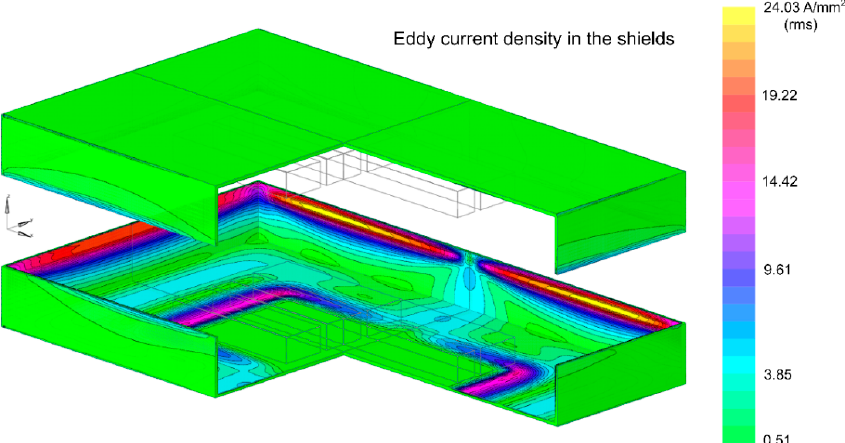
Figure 6. Eddy current density distribution in the shields when only the lower winding is fed. The maxima occur near the edge of the longer sides of the shield. Eddy currents (as well as all the other causes of losses in the ferrite) are neglected.